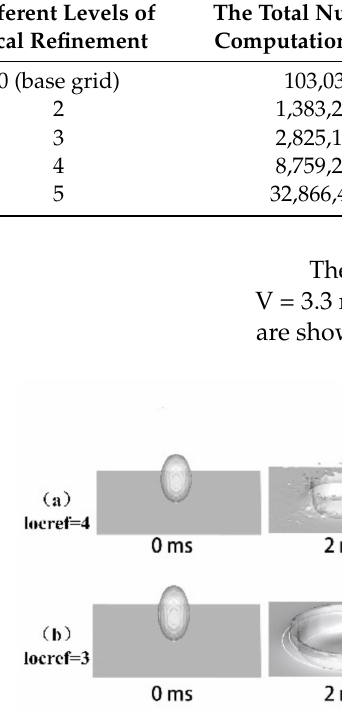
Figure 2. Numerical simulation results of the droplet splash process under two different levels of local refinement. ( a ) Simulation of a droplet splashing with four levels of local refinement (locref = 4) and ( b ) simulation of a droplet splashing with three levels of local refinement (locref = 3).